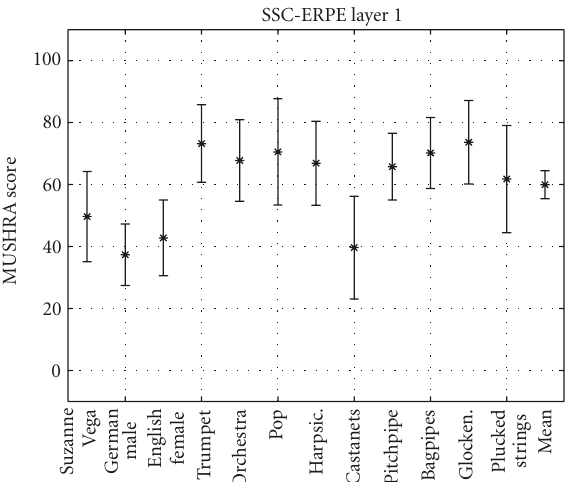
Figure 14: Listening test results per excerpt for SSC-ERPE Layer 1 (28Kbit/s stereo).